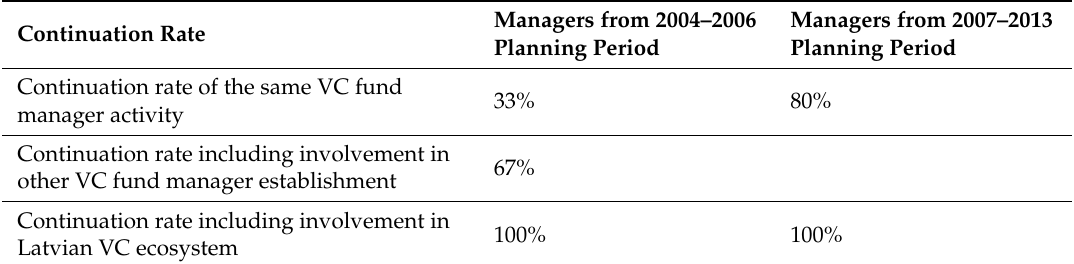
Table 4. Continuation rate of the VC fund